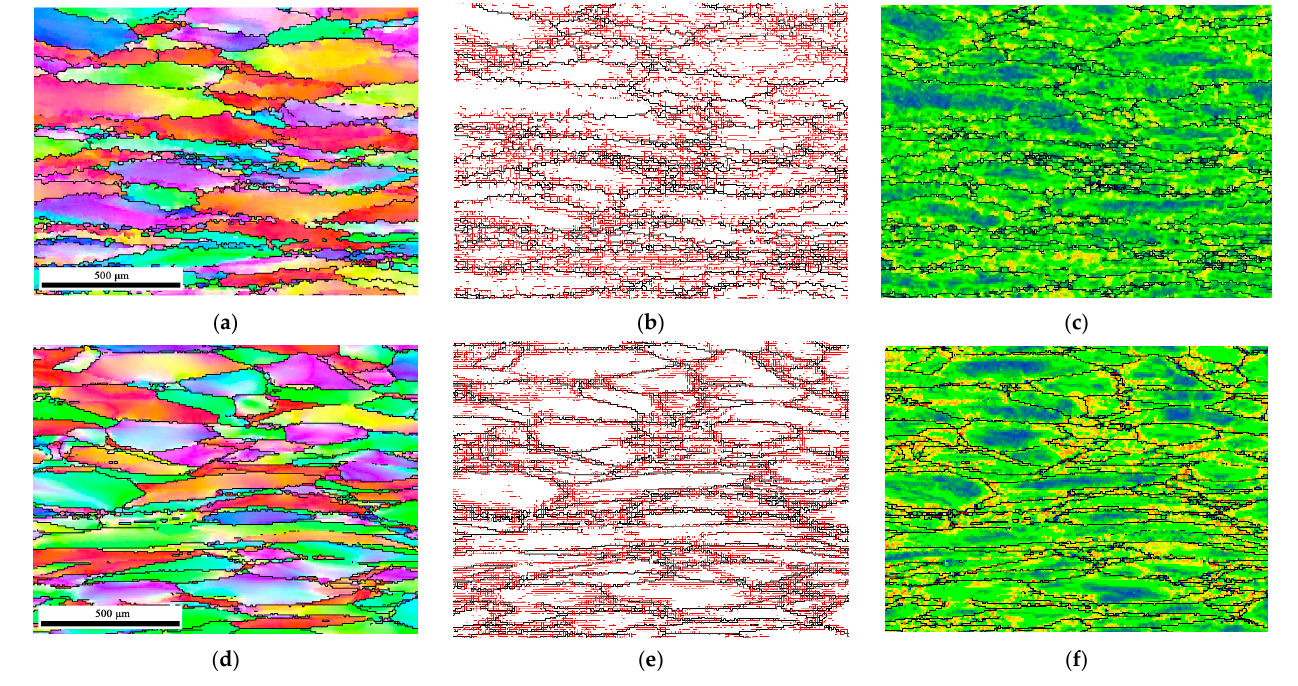
Figure 9. ( a , d ) IPF map, ( b , e ) GB map, and the ( c , f ) KAM map of medium η regions. Region E had a η of around 0.37 and is characterized by a medium strain rate (0.1 s − 1 )